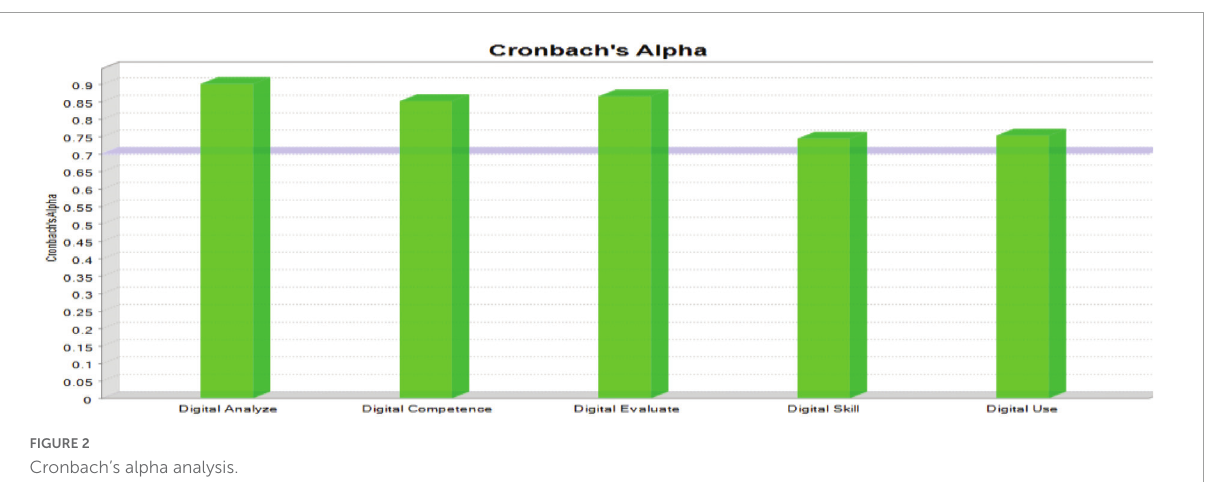
FIGURE2 Cronbach’s alpha